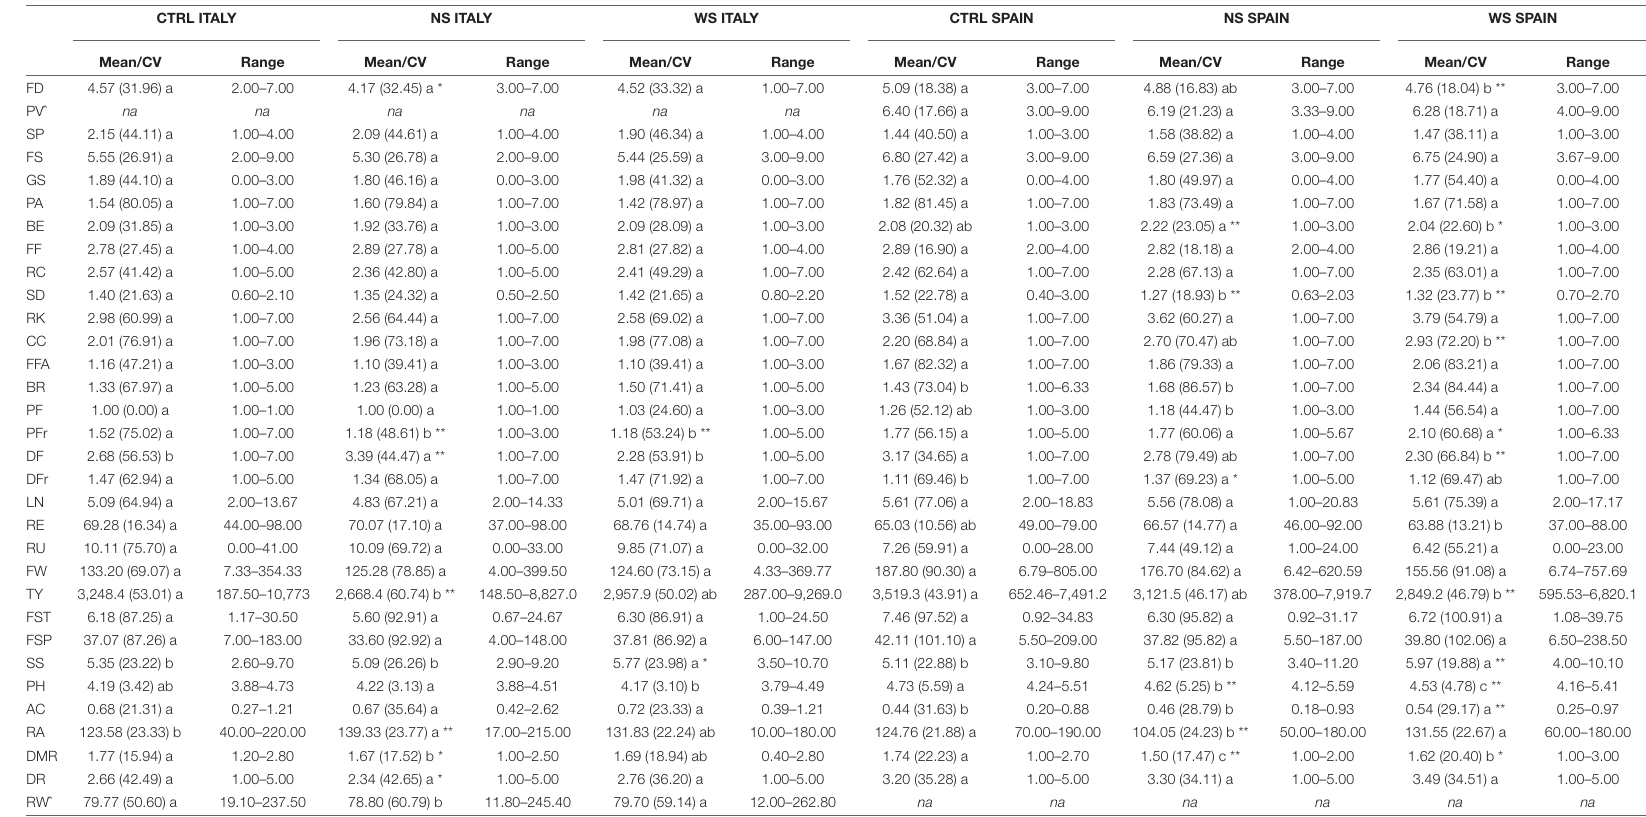
ˆData available from single locations. *Significant different respect the control at p < 0.05; **significant different respect the control at p < 0.01. For traits within each location, means with different letters are significantly different (Tukey’s HSD, p = 0.05). Means with asterisk are statistically significant in comparison to the respective control (Dunnett’s). The full name of each trait abbreviation in the first column can be found in Table 2